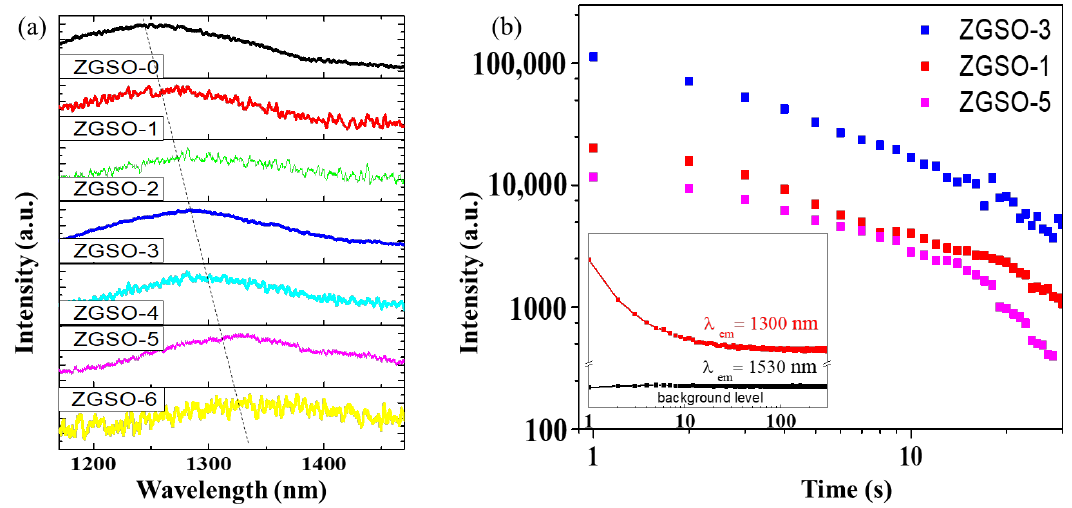
Figure 5. ( a ) Persistent luminescence spectra of the ZGSO-0–ZGSO-6 samples (1 min after ceasing UV excitation). ( b ) Corresponding decay curves of the ZGSO-1, ZGSO-3, ZGSO-5 samples after removing UV excitation. The inset presents the time dependence of the NIR persistent luminescence intensity of emission wavelength at 1300 nm and 1530 nm for Er 3+ , Ni 2+ co-doped ZGSO-3. The emission at 1530 nm is at around the background level. All samples were excited using a 365 nm UV lamp for 5 min.